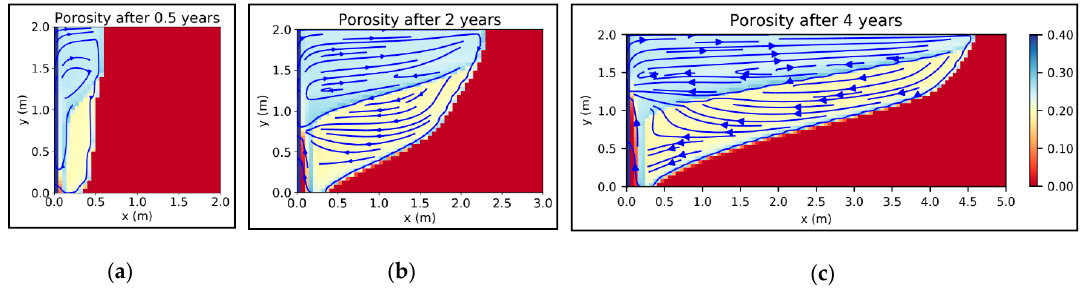
Figure 14. Porosity distribution within an ( a ) initially reaction- and advection-dominated system; ( b , c ) in the long run transport-dominated and with an increasing influence of diffusion (scenario: dissolution rate 10 − 5 cm/s and 25 wt.% carnallite).